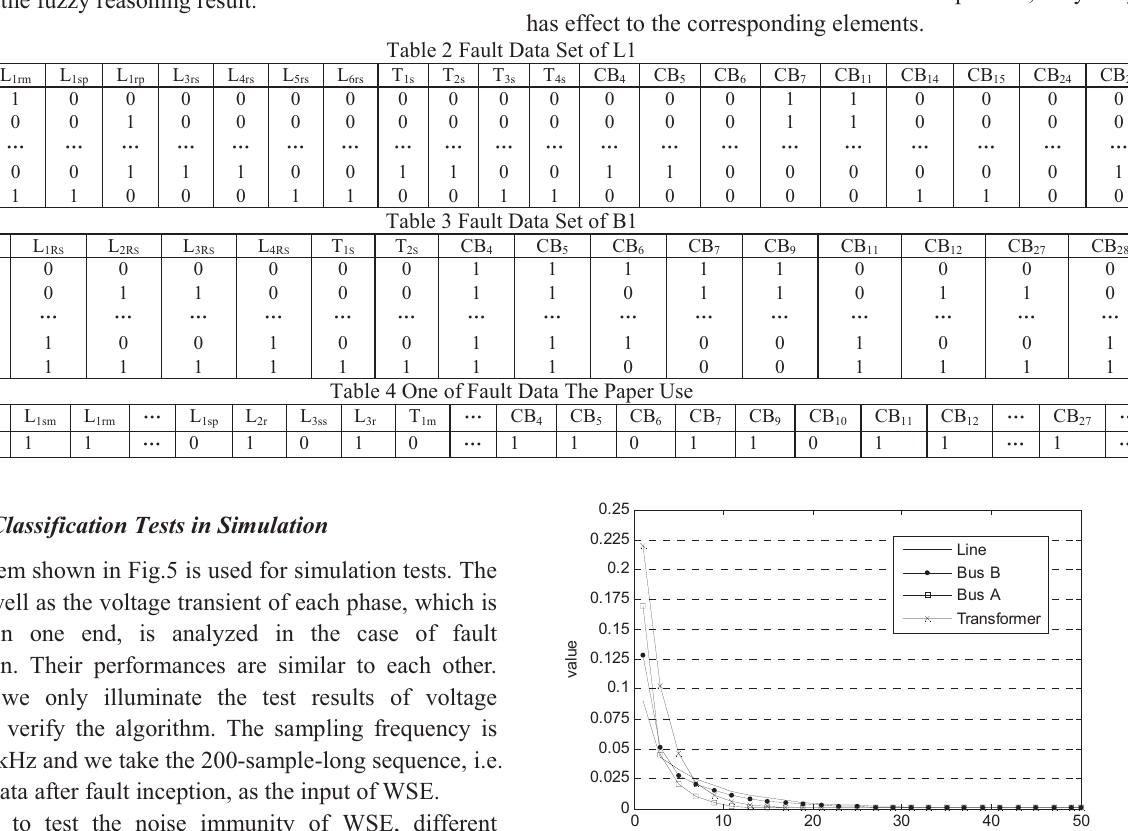
Fig. 5 Error curves of above four models in 50 times